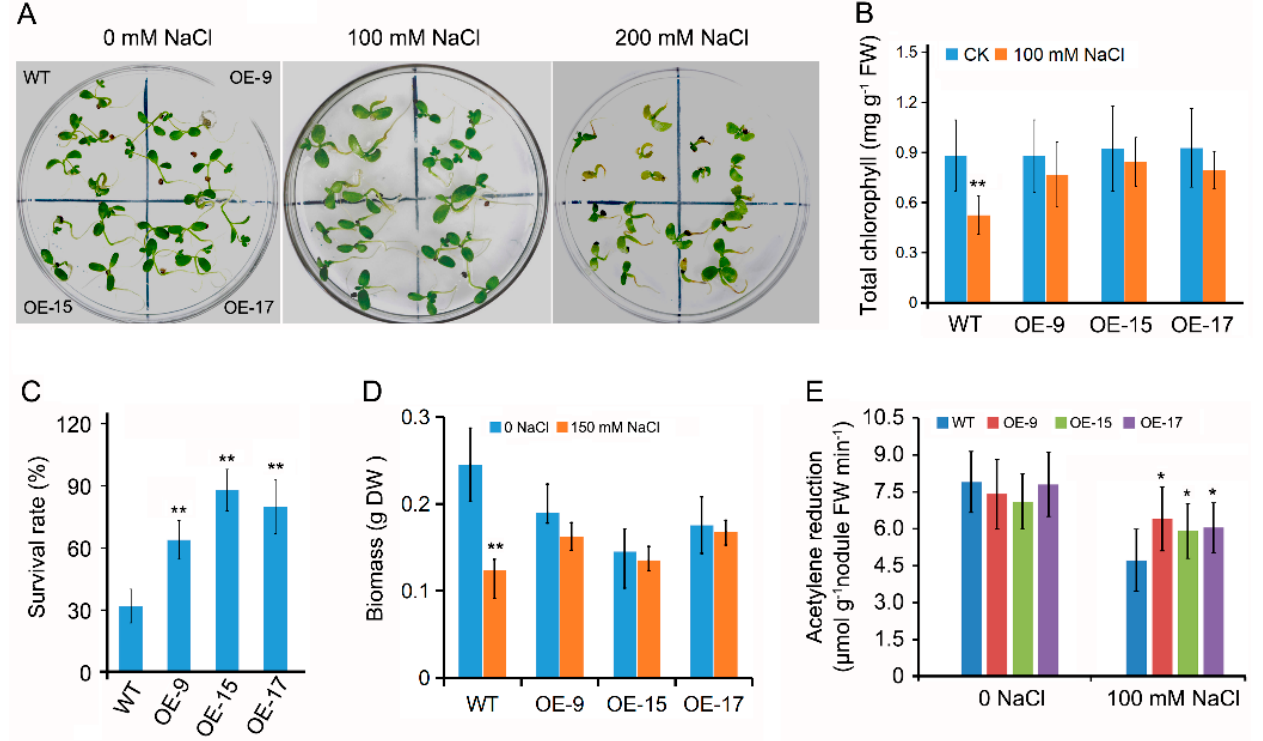
Figure 2. Salt stress tolerance evaluation of OELjPLT3 plants. ( A ) The phenotype of seedlings treated with different concentrations of NaCl. Three-day-old seedlings grew on 1/4 B&D medium with 100 or 200 mM NaCl, photographs taken 7 days later. ( B ) The chlorophyll concentration of seedlings shown in ( A ) under 100 mM NaCl treatment. ( C ) The survival rate of seedlings shown in ( A ) under 200 mM NaCl treatment. ( D ) The biomass of plants after 200 mM NaCl treatment (acclimation). Treatments were applied to ten-day-old plants for 30 days. ( E ) Results of the acetylene reduction assay after 100 mM NaCl treatment. Three-day-old seedlings were inoculated with M. loti. 100 mM NaCl treatments were applied after inoculation of rhizobia for 4 weeks and then nodules were col- lected 1 week later. 15–20 plants in different lines were used in ( B , C ). 4–6 plants in different lines were used in ( D ). Error bars represent the SD of three biological replicates. The significant differ-